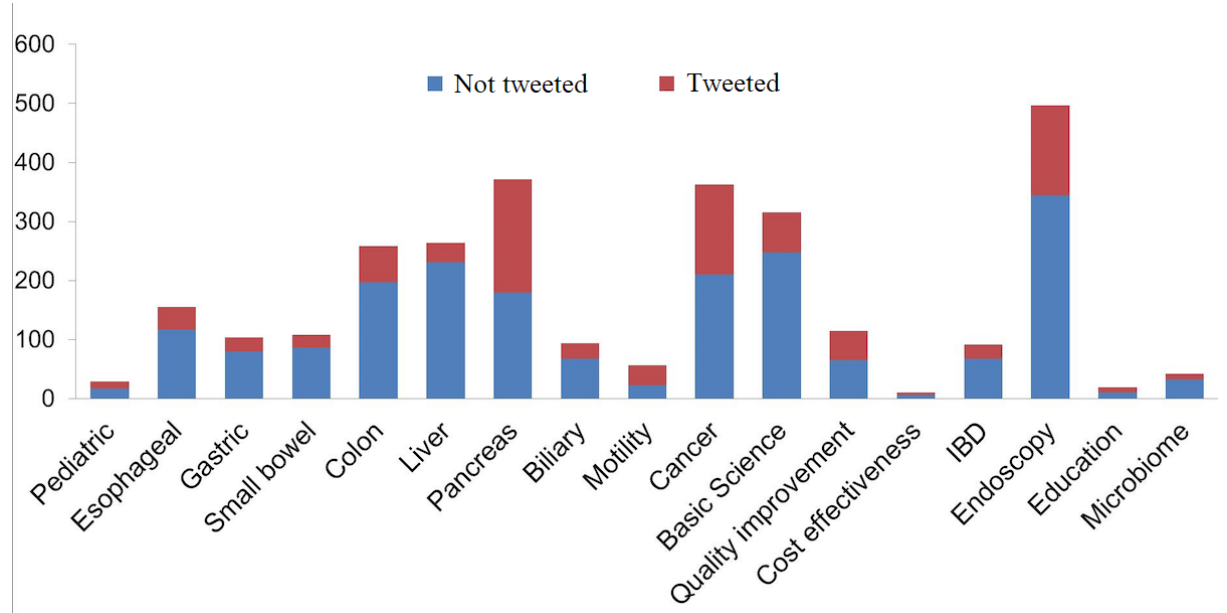
Figure 2. Number of publications (both tweeted and nontweeted) in 2012 by subtopic among the five journals included. IBD: inflammatory bowel disease.